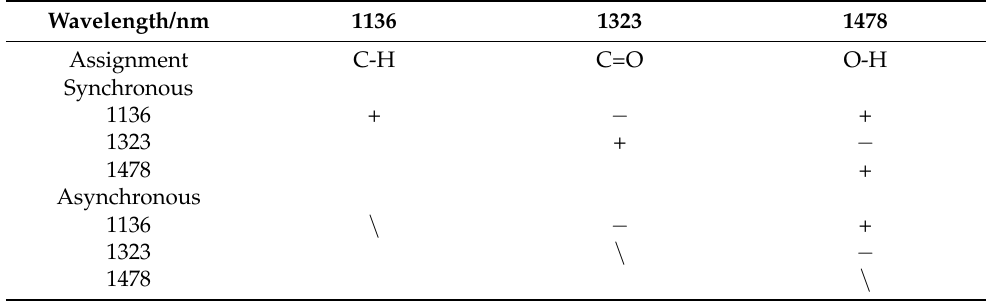
Table 5. Cross peak sign of two–dimensional correlation spectrum of Ala content in the NIR band. Wavelength/nm 1136 1323 1478 Assignment C-H C=O O-H